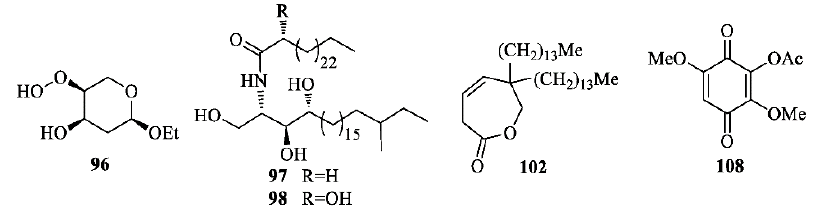
Figure 7. Miscellaneous compounds isolated from Iris germanica .